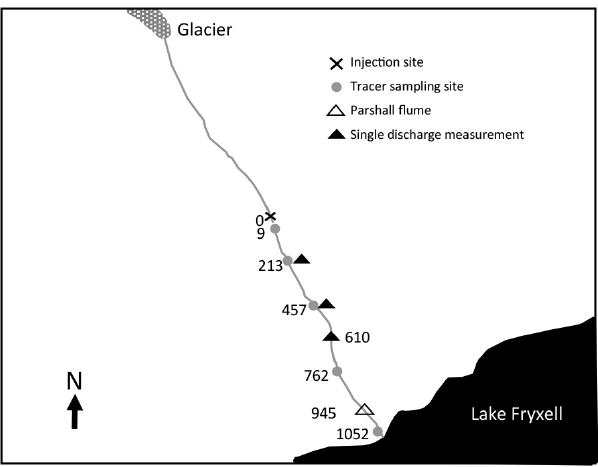
Figure 19. Huey Creek tracer study site map (Runkel et al.,